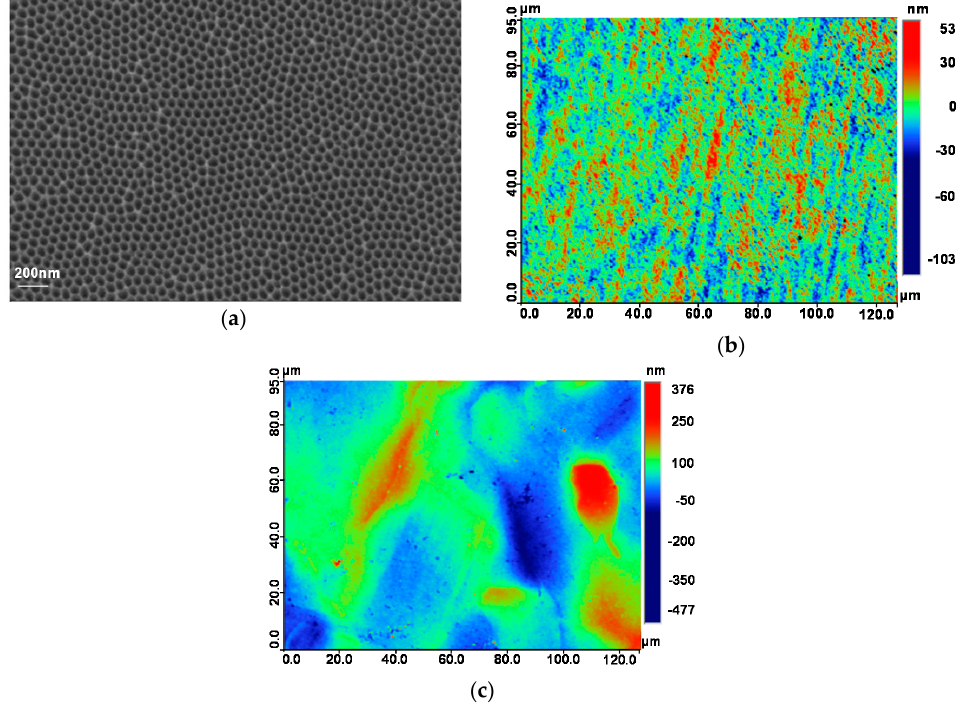
Figure 5. ( a ) SEM image of the lenslet mold apex region. ( b ) Surface roughness of the nanostructured pin mold (Sa = 9.161 nm). ( c ) The lens mold 3D microtopology after one replication (Sa = 48.939